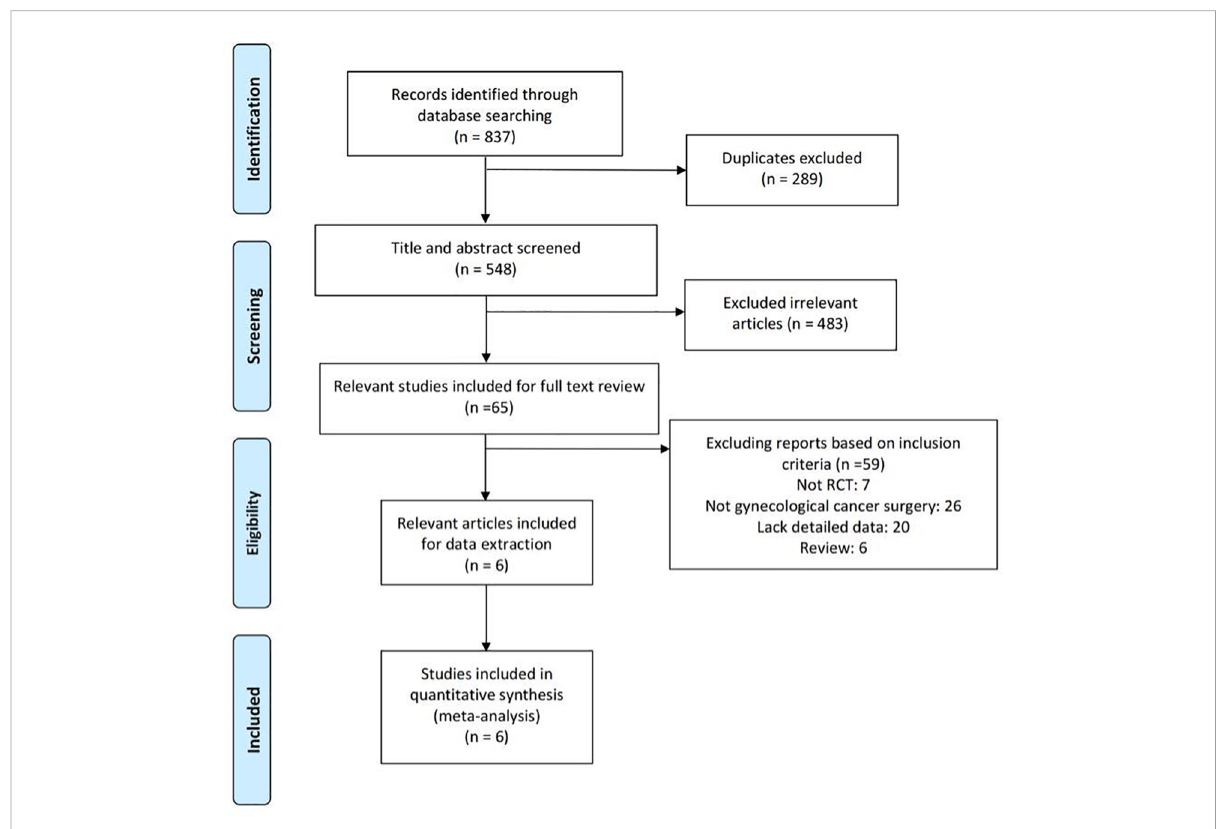
FIGURE 1 The fl owchart of search